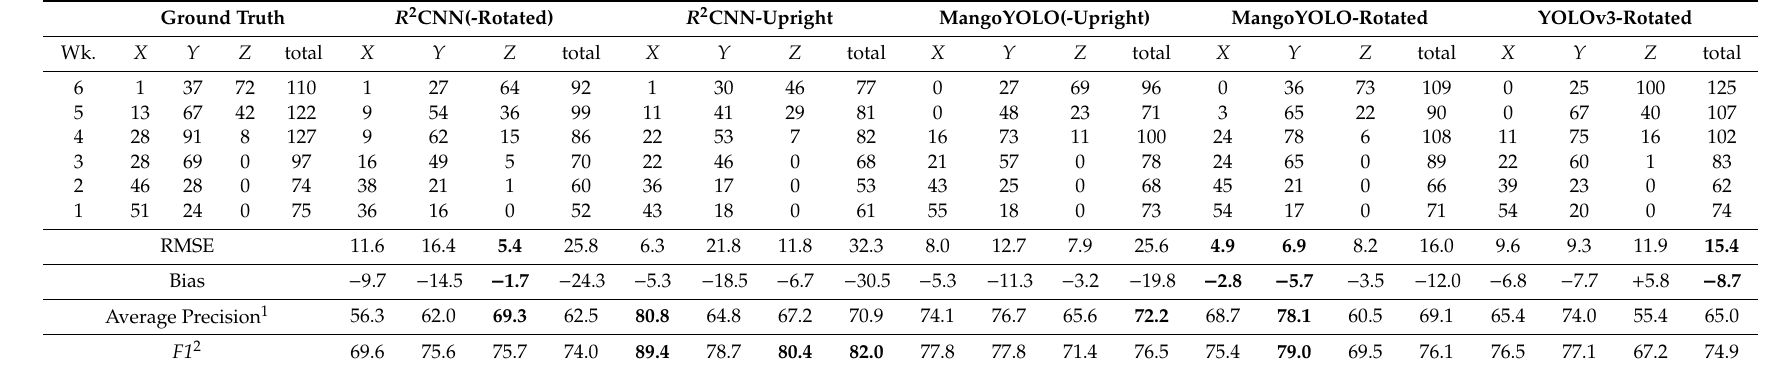
Table 4. Stage detection results on the validation set using three methods. RMSE refers to a comparison with ground truth assessments of panicles per image. All values refer to number of panicles per tree image. Best results for a given metric and panicle stage are shown in bold. Ground Truth R 2 CNN(-Rotated) R 2